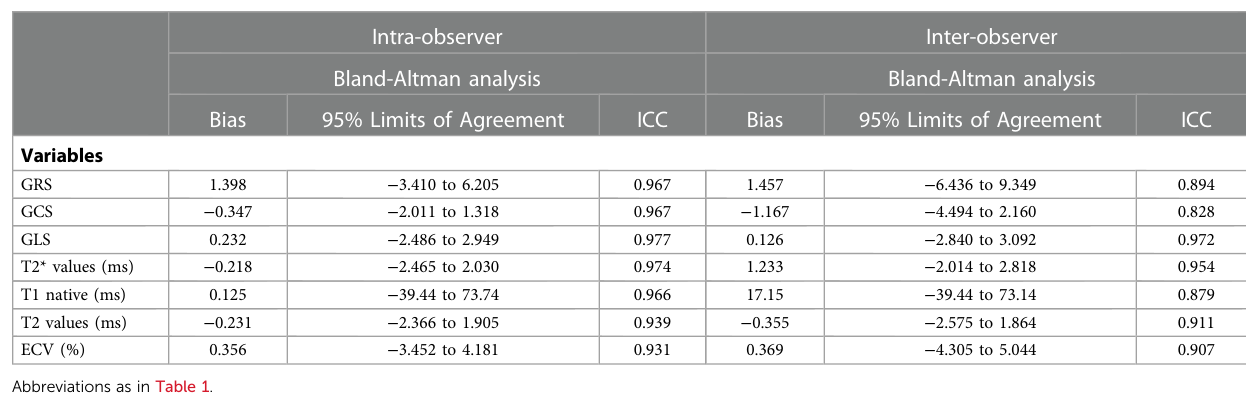
TABLE 4 Reproducibility of CMR parameters.